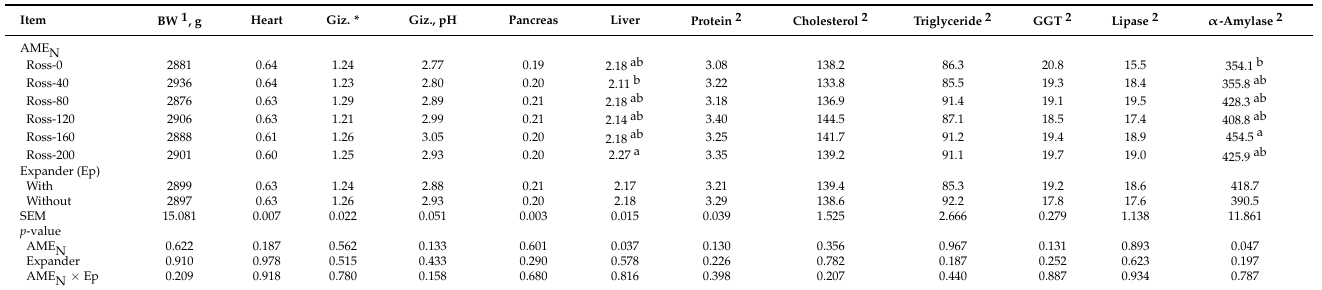
Table 11. Broiler internal organs, blood serum health indicators from broilers slaughtered at 36 days,